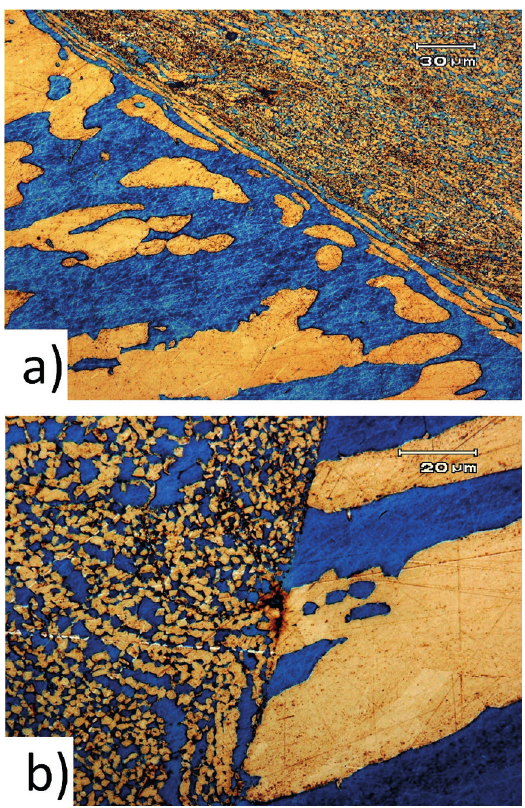
Figure 6: Micrographs of 18 kN showing insufficient mixing and lack of bond.